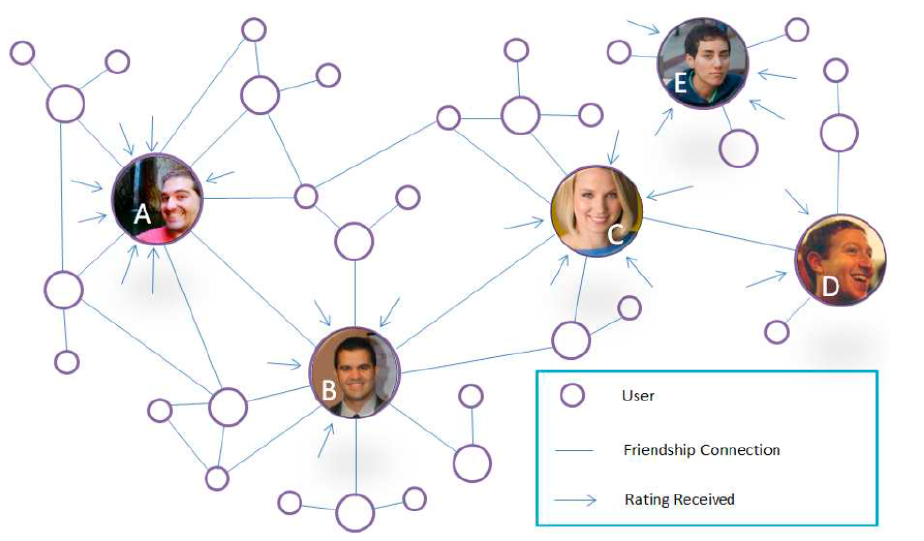
Figure 2. Example of Graph Representing Friendship in a Social